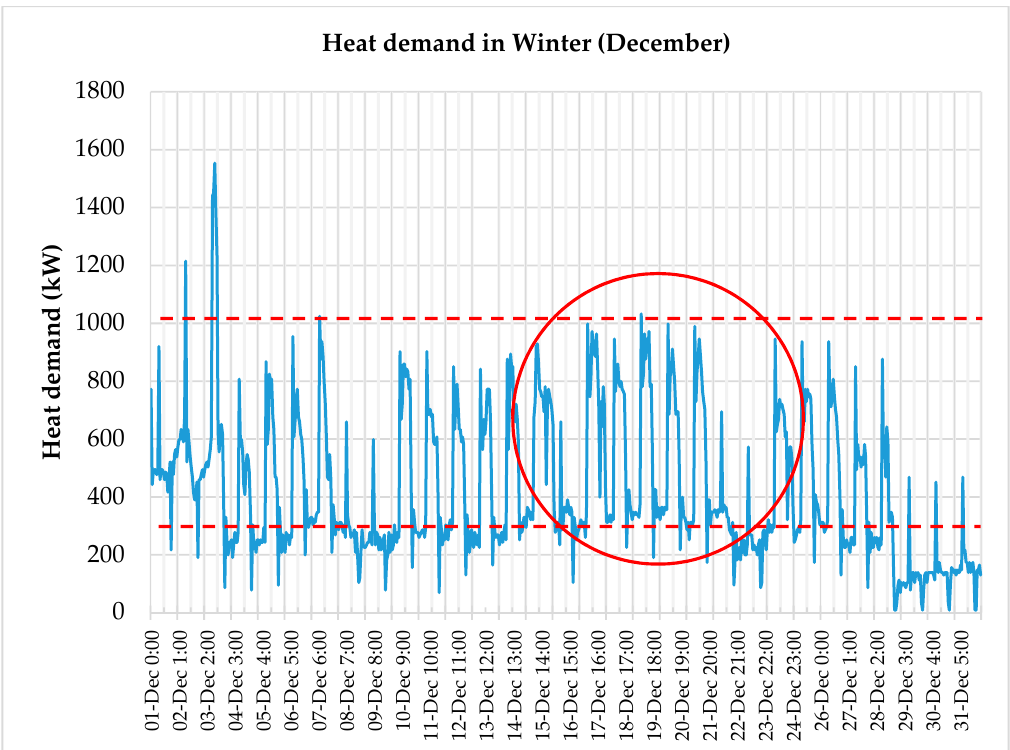
Figure 12. Heat demand in December.